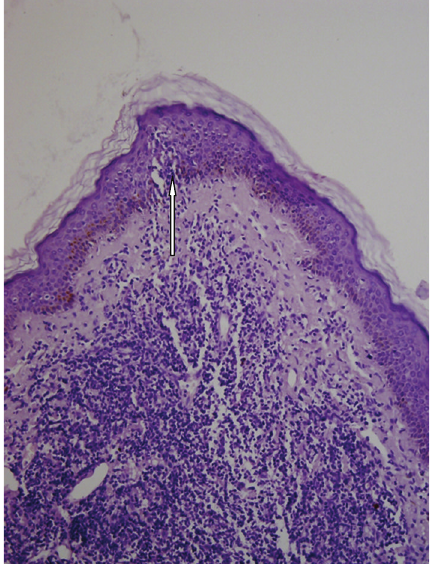
Figure 2: Histopathology: lymphoid dermal proliferation infiltrat- ing epidermis (arrow) hematoxylin-eosin (10x).